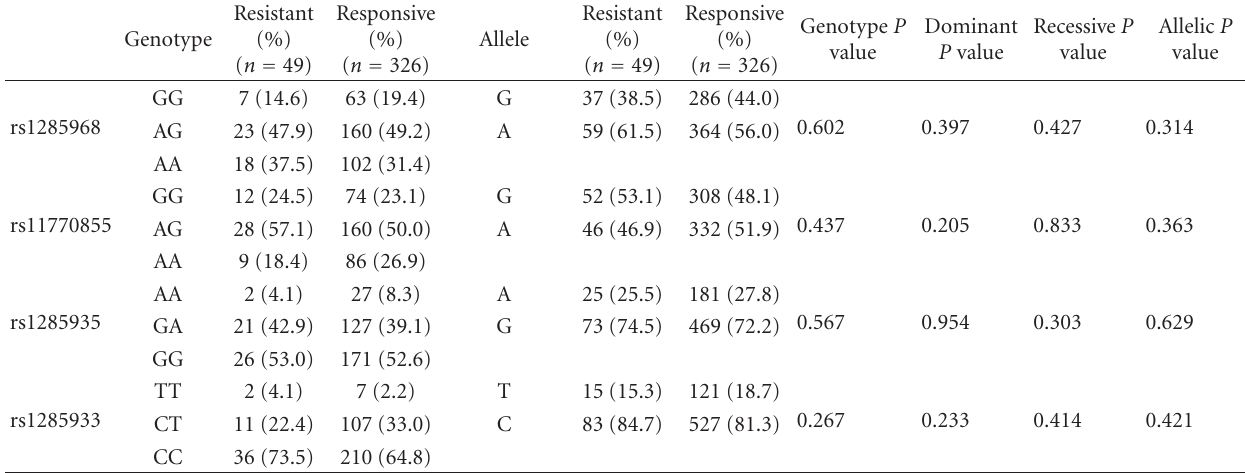
Table 4: Genotype and allele frequencies of the CLEC5A gene in patients with Kawasaki disease responding or not responding to intravenous immunoglobulin (IVIG)